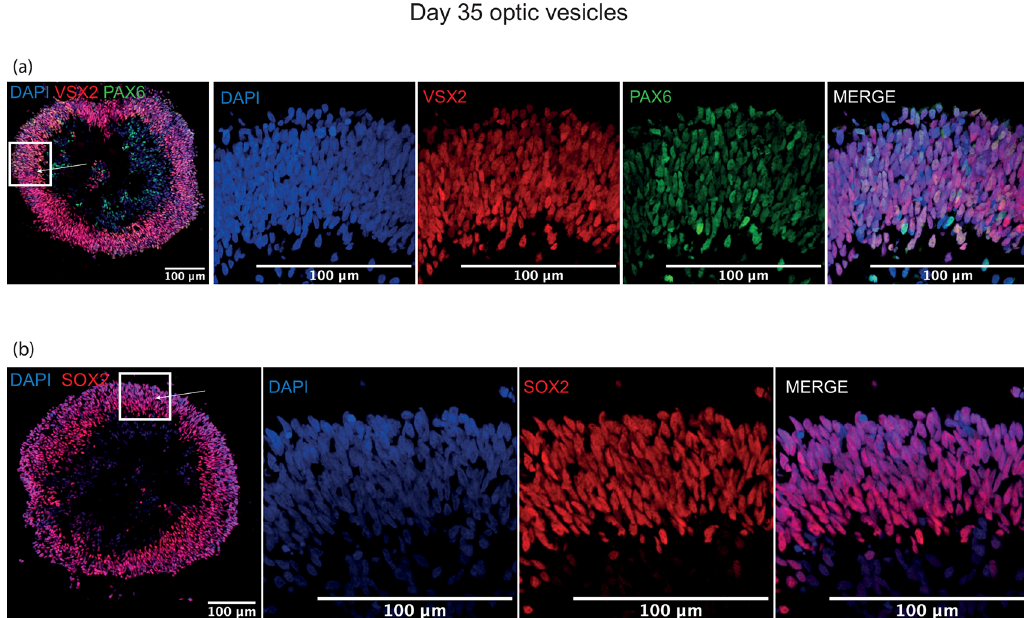
Figure5.Representativeimagesofimmunohistochemistrysectionsofdifferentiatingopticvesiclesatday35. Thick cellular layers of neuroepithelium are present in optic vesicles at day 35 expressing (a) early retinal progenitor markerVSX2co-expressed withoculardevelopment masterregulator PAX6,and(b)retinalprogenitormarkerSOX2. Arrows indicate neuroepithelial layer seen in zoomed